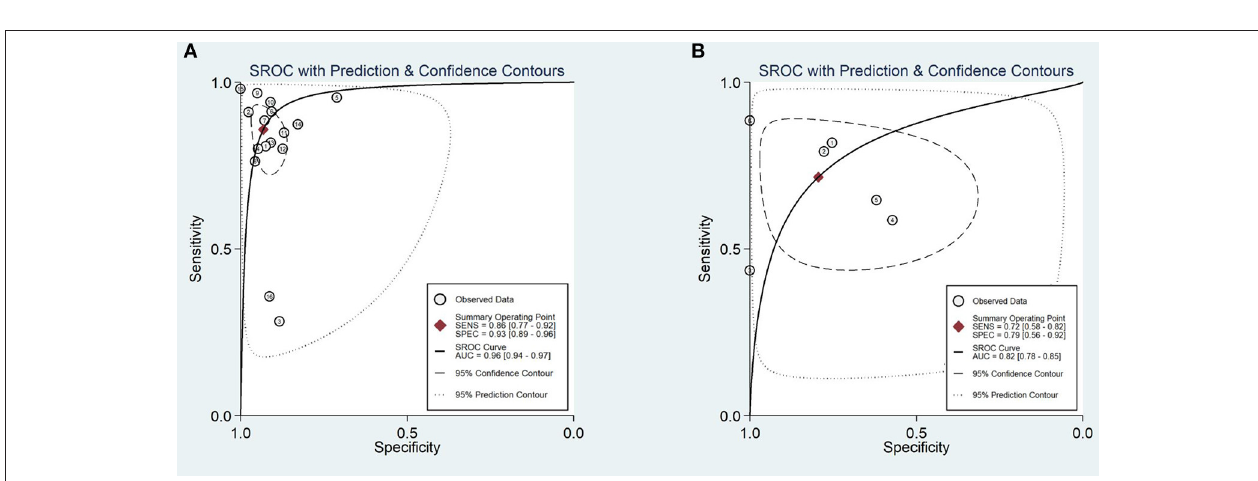
FIGURE 3 | The forest plot of pooled sensitivity and specificity of AI distinction depth on EGC. The pooled sensitivity was 72% (95% CI, 58–82%) and specificity was 79% (95% CI, 56–92%).